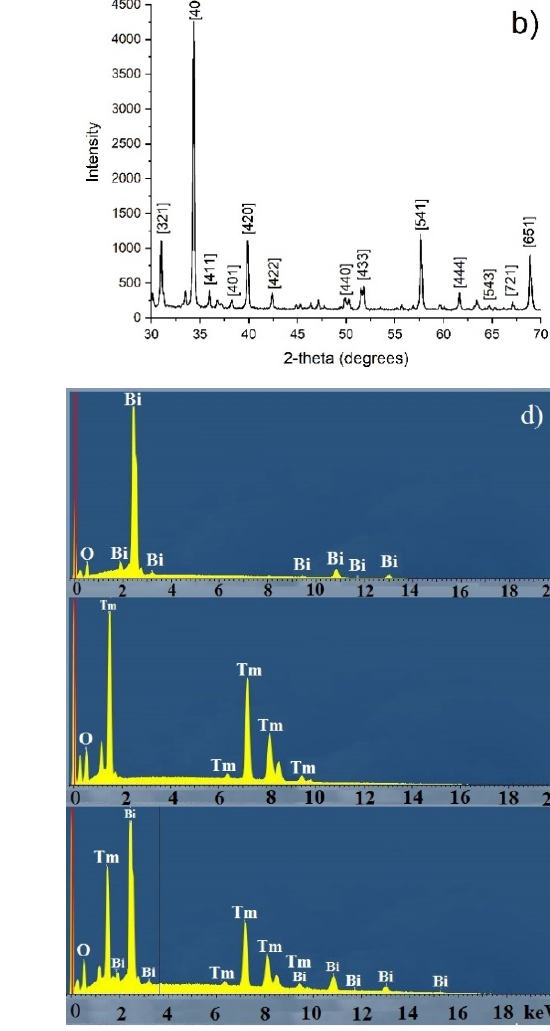
Table 1. The most intense XRD pattern reflections characteristic of the Bi 2 O 3 and Tm 2 O 3 content in the Bi 2 O 3 /Tm 2 O 3 (28 at.%).